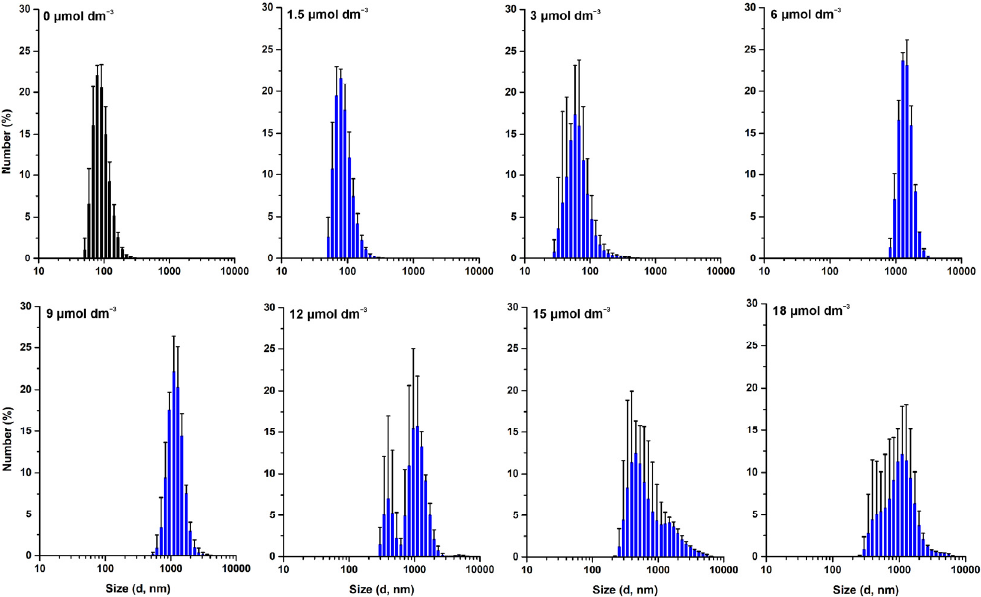
Figure 6. Size distribution of the POPE:POPG (1:1) LUVs in the presence of W-BP100 from the DLS measurements. Number-weighted size distribution of 100 µmol dm − 3 POPE:POPG (1:1) LUVs in the absence and presence of increasing W-BP100 concentrations (1.5-18 µmol dm − 3 ), upon 10 min of incubation, at 25.0 ± 0.1 °C. Data are the mean ± SD of three replicate measurements (one single experiment).